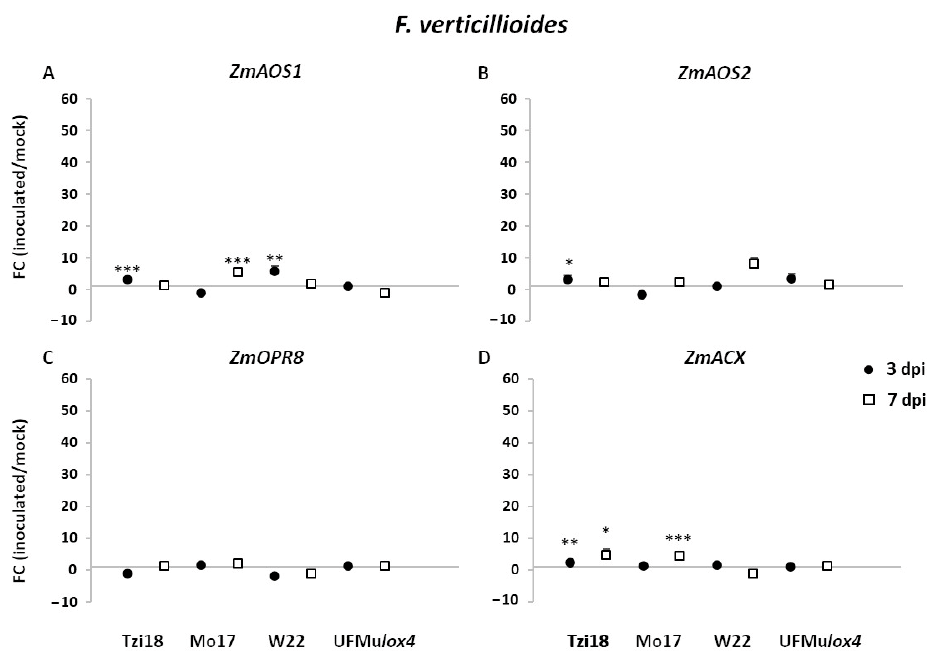
Figure 6. RT-qPCR analysis of maize oxylipin- and JA-related genes upon F. verticillioides inoculation. Fold change (FC) of expression between inoculated and mock kernels of Tzi18, Mo17, W22, and UFMu lox4 lines at 3 (circle) and 7 (square) dpi with F. verticillioides . ( A ) ZmAOS1 , ( B ) ZmAOS2 , ( C ) ZmOPR8, and ( D ) ZmACX . Vertical bars indicate the standard error. Asterisk denotes significant upregulation/downregulation with 2-fold or higher FC using Welch’s t-test (* p ≤ 0.05; ** p ≤ 0.01; *** p ≤ 0.001).